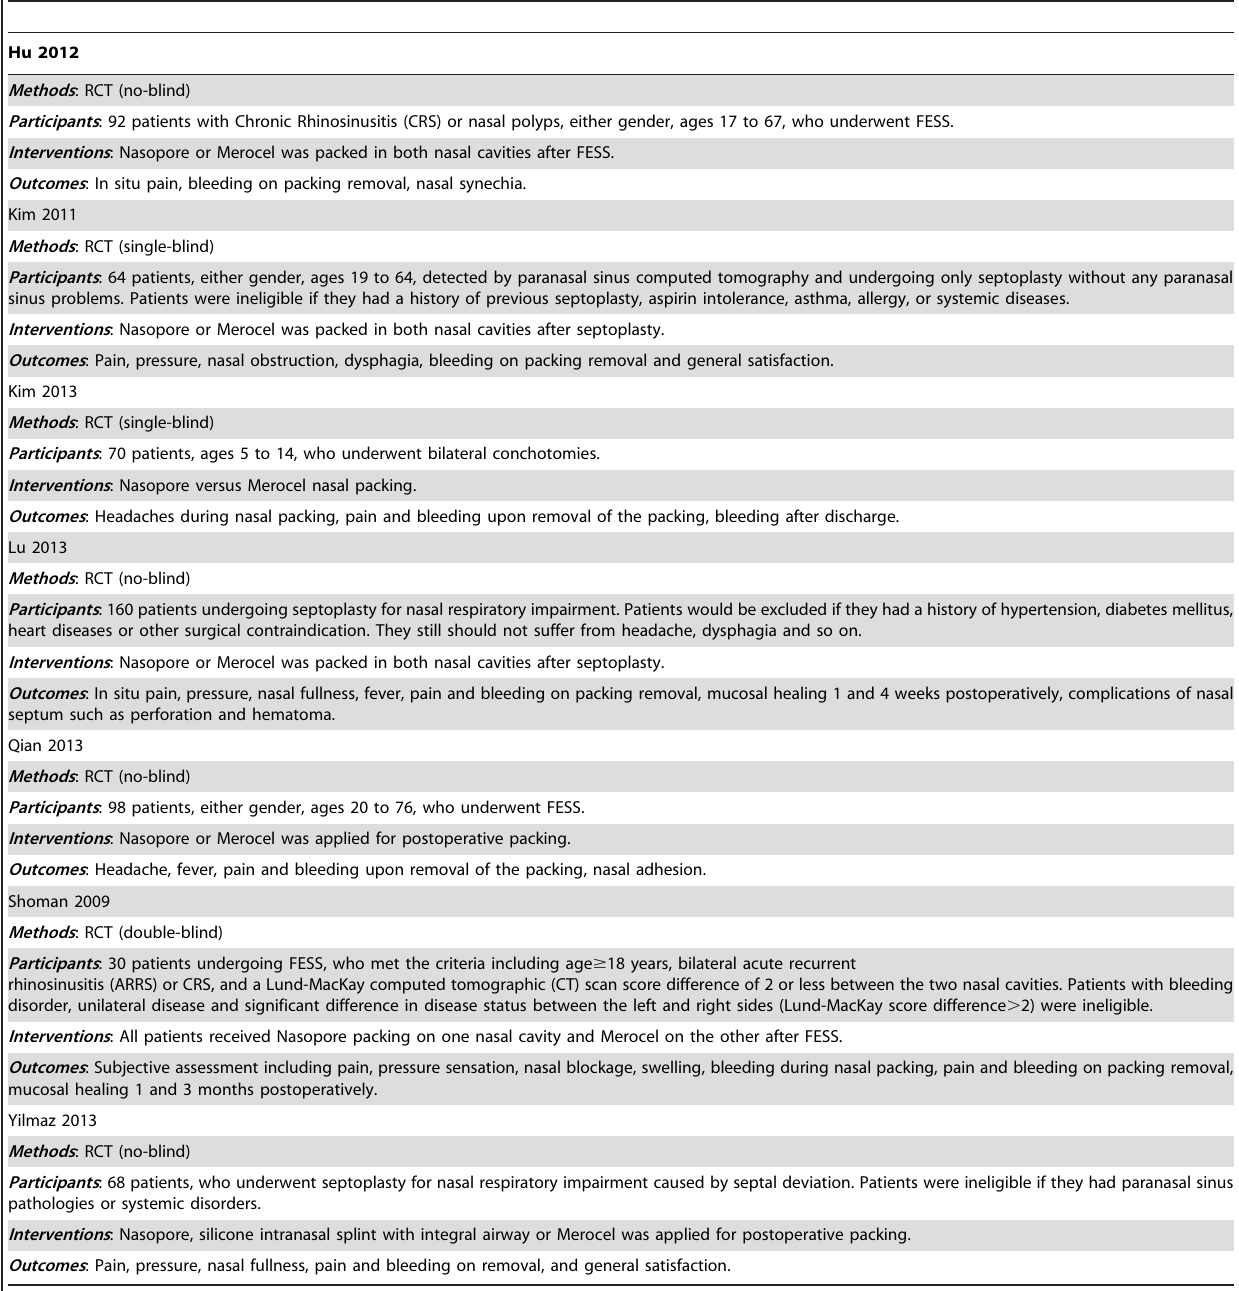
Table 1. Individual